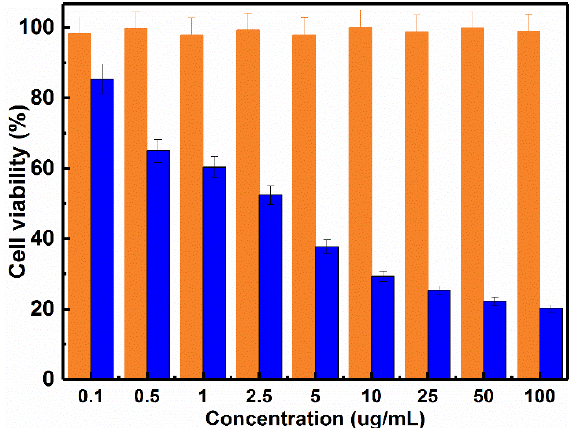
Figure 4. The effect of MIL-100(Al) gels and DOX-loaded MOGs with various concentrations on the cell viability of HeLa cells in 24 h (the orange and blue bars represent the viability of HeLa cancer cells incubated with MIL-100(Al) gels and DOX-loaded MOGs, respectively).